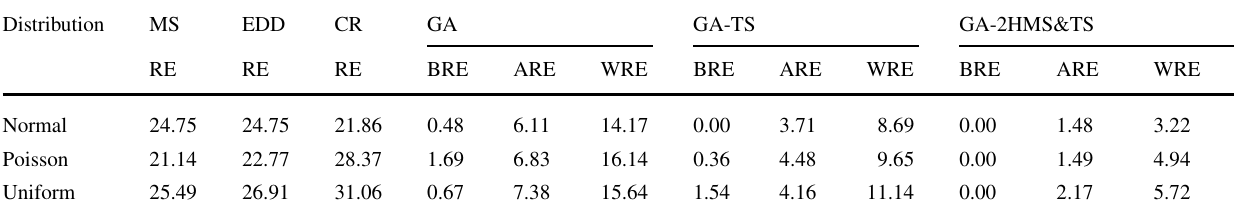
Table 10 RE of different algorithms for different distribution conditions